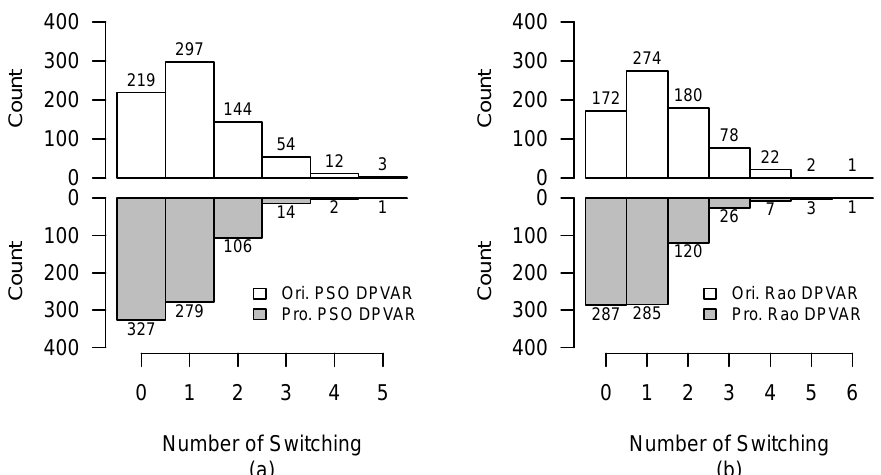
Figure 22. Comparison of switching operation of original-reconfigured and proposed-reconfigured PV arrays under Case 1 without lagged time. ( a ) PSO-reconfigured PV array. ( b ) Rao-reconfigured PV array.